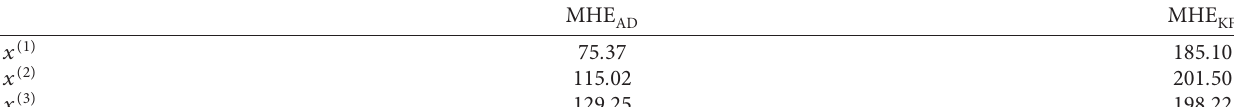
Table 3: Average sum square estimation error (example 2).